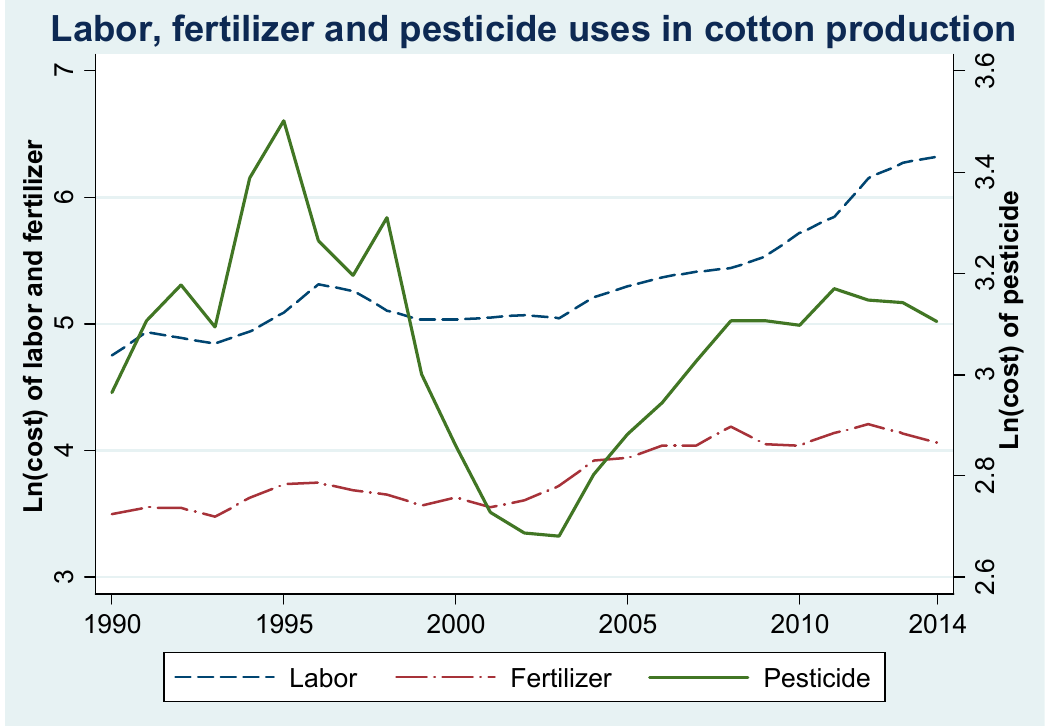
Figure 4. Fertilizer, pesticide and labor inputs of cotton over time.